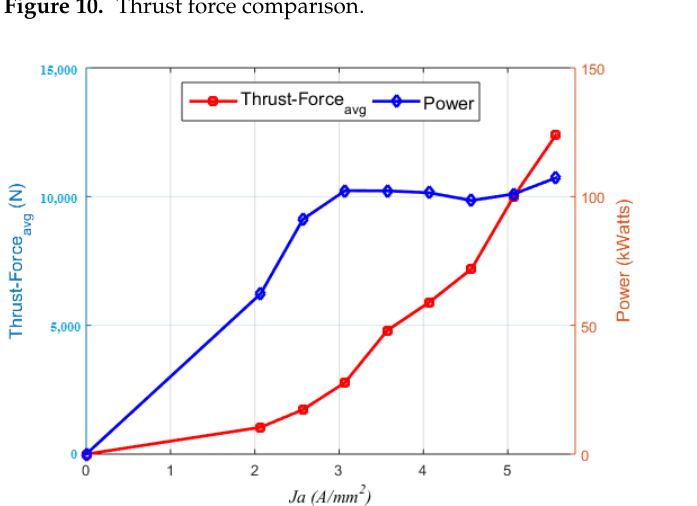
Figure 11. Average thrust force and power versus variable armature current